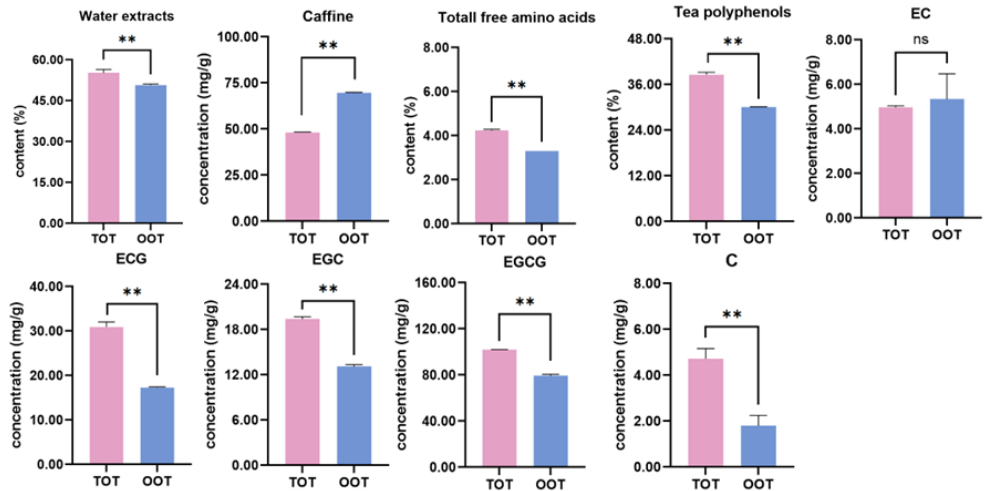
Figure 5. Test results of the main taste components of TOT and OOT (based on triplicate analyses). t -test was used to identify significant differences (ns = not significant; ** p < 0.01).